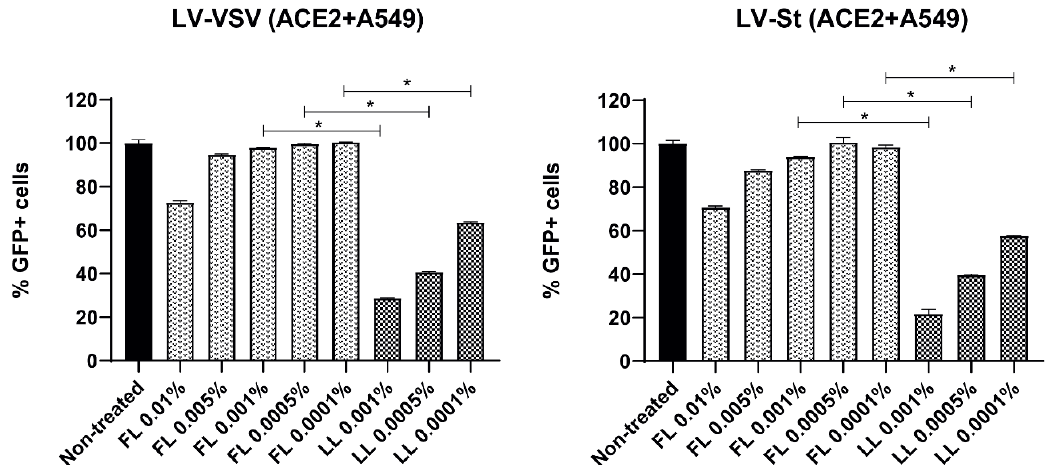
Figure 2. Comparison of the antiviral effect of free and liposomal bovine lactoferrin against LV-VSV and LV-St pseudoviruses in ACE2+A549 cells. The cells were incubated during all steps with either FL or LL at a specific range of concentrations and were subsequently infected with its corresponding virus at an MOI of 0.1. Columns represent the mean percentage of GFP+ cells compared to untreated cells. Triplicate experiments were performed for each data point ( n = 3), and the value is presented as mean percentage of infection/viability ± S.D. * p < 0.05 was considered statistically significant. The antiviral effect of bLf against HCoV-299E was also assayed. Huh-7 cells were subjected to infection in the presence of FL or LL during all steps. At 48 h p.i., cells were collected and analyzed by flow cytometry. Huh-7 cells treated with bLf showed a decrease in infection; this effect was significantly greater in those treated with LL in comparison to those treated with FL (Figure 3).